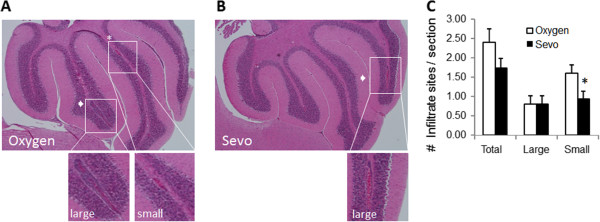
Sevoflurane reduces leukocyte infiltration in experimental autoimmune encephalomyelitis (EAE). Representative sagittal sections from (A) oxygen-treated and (B) sevoflurane-treated mice were stained with hematoxylin and eosin to detect infiltrating cells. Arrows indicate large (>5,000 μm2) sites of infiltration; asterisks indicate smaller (<5,000 μm2) sites. The lower images show magnified areas as indicated. (C) The total number of sites of infiltration was quantified as large or small. Data are mean ± SEM of n = 5 sections per animal, three mice in each of the two treatment groups; *P <0.05 versus oxygen.